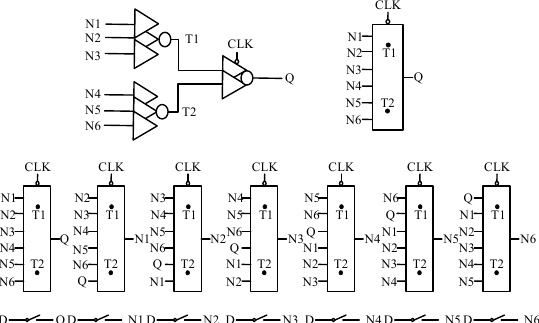
Figure 6. Latch schematic for TNURL.